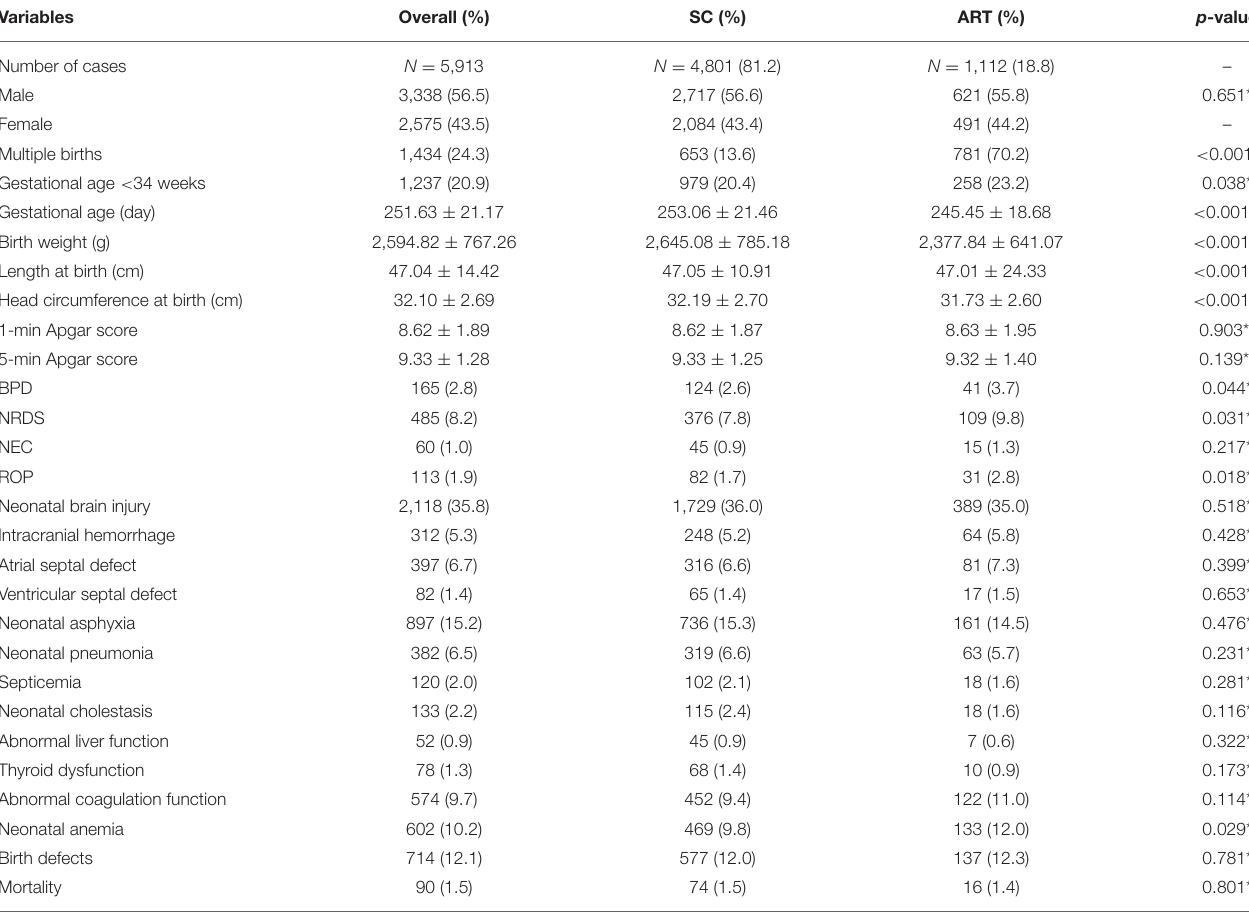
TABLE 3 | Neonatal outcomes between the SC and ART groups.